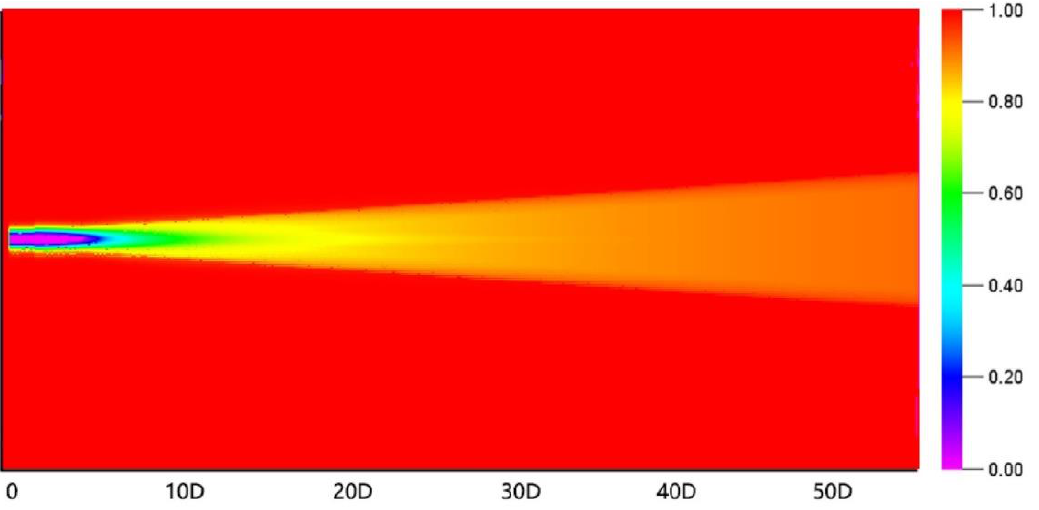
Figure 6. Single-wake wind speed by Deep Array EV wake model.